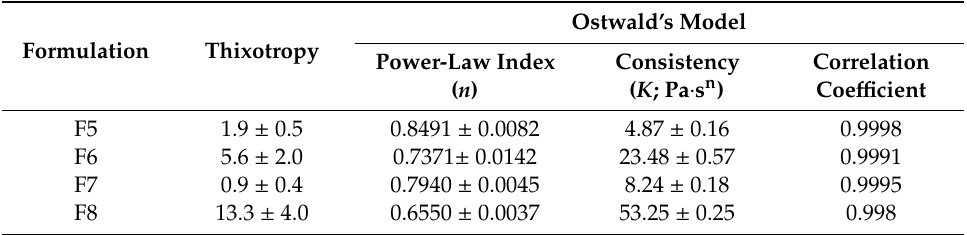
Table 5. The rheological parameters calculated from steady shear analysis in the controlled rate (CR) mode.